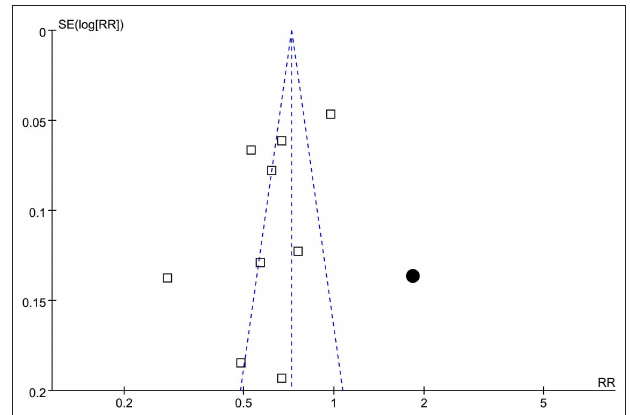
FIGURE 5 | Funnel plots with trim-and-fill analyses for the publication bias underlying the meta-analysis of the association between statin use and active tuberculosis infection; the blank squares represent each of the included study, and the black circular indicates the imputed study with negative result.